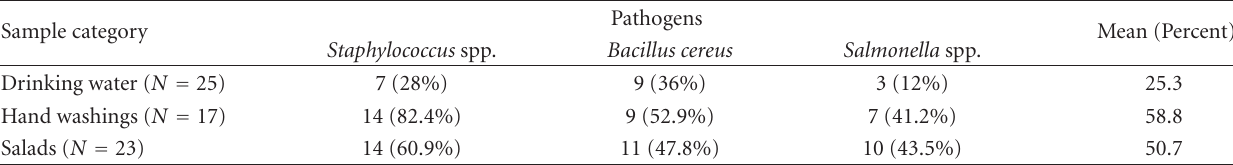
Table 3: Microbiological quality of salads, drinking water and hand